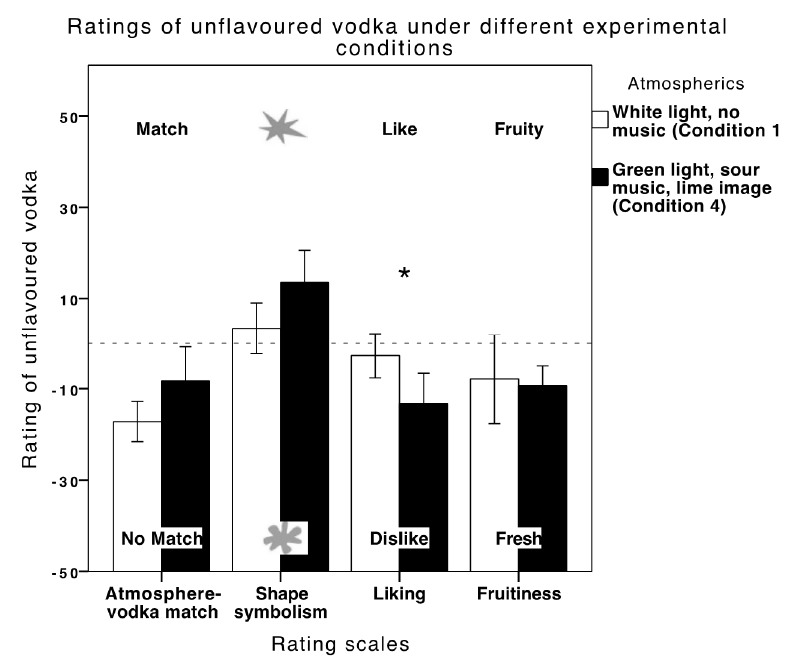
Figure 2. Participants’ ratings of the unflavoured vodka under two different conditions. In Condition 1, there was standard white room lighting and no music. By contrast, in Condition 4, the ambient lighting was green, putatively sour music was played (see Knoeferle et al. , 2015 [9]), and the picture of a lime was projected on a large screen in front of the participants. Each scale was 100 mm long, with the 0 point corresponding to the midpoint of the scale, shown by the dashed line in the figure. The y -axis reflects the distance of participants’ responses from the midpoint, from − 50 mm to 50 mm. The asterisks highlight a significant difference between the conditions ( p < 0.05). The error bars represent the standard error of the